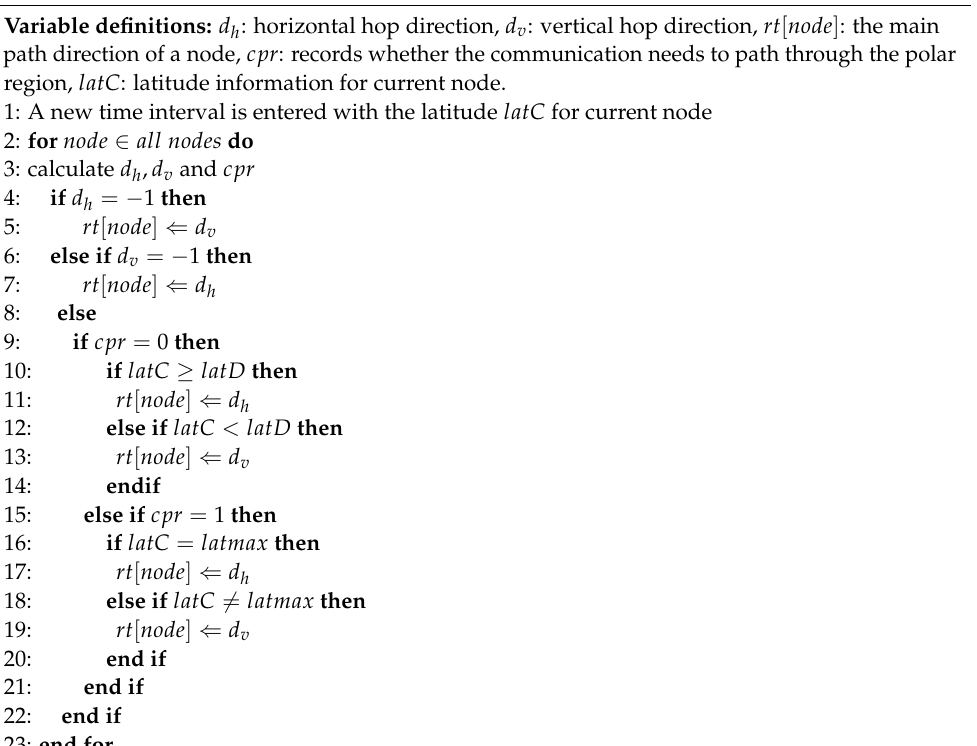
Algorithm 1 Main path direction